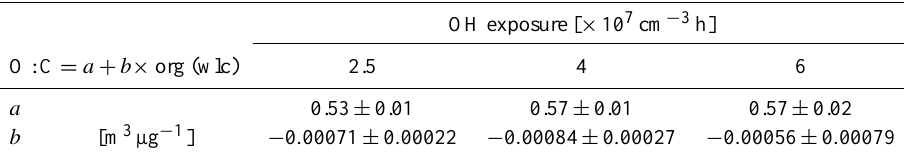
Table 3. Slopes and intercepts of linear (least orthogonal distance) fits between O:C and org (wlc). Fit lines are shown in Fig. 3 with the OH exposure as color